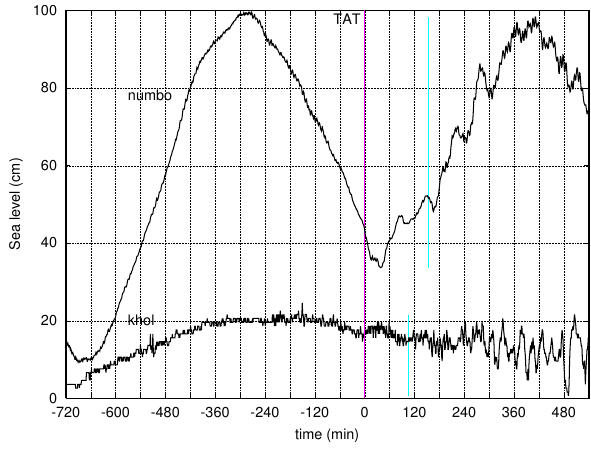
Fig. 3a. Sea level records of gauges in Nouma-Numbo, French New Caledonia (numbo), and in Kholmsk, on the south-west coast of Sakhalin island, Russia (khol). Records still include tide. Records are shown as examples of problematic identification of the TAT and of the first wave period P1. The estimated end of the first wave is indicated by a light blue line. Time is measured from the